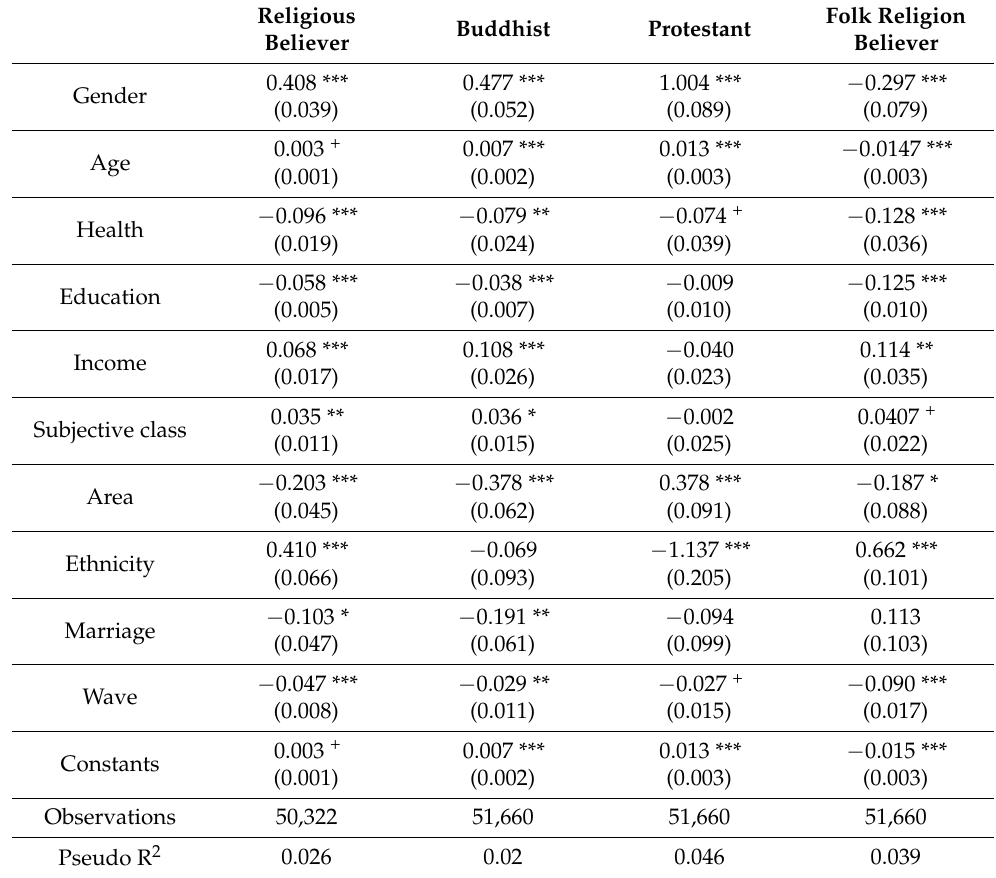
Table 4. Binary logistic regression model for the likelihood of believing in